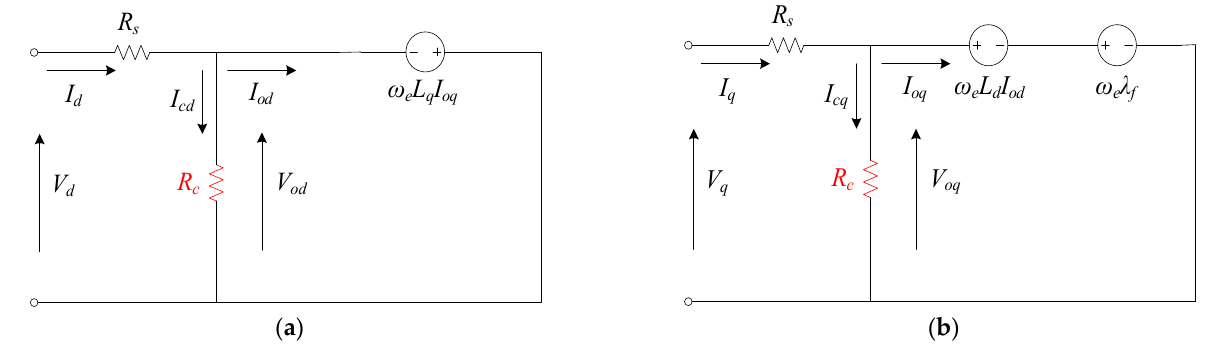
Figure 12. ECM of PMSMs with predictable core loss: ( a ) d -axis; ( b ) q -axis [25].